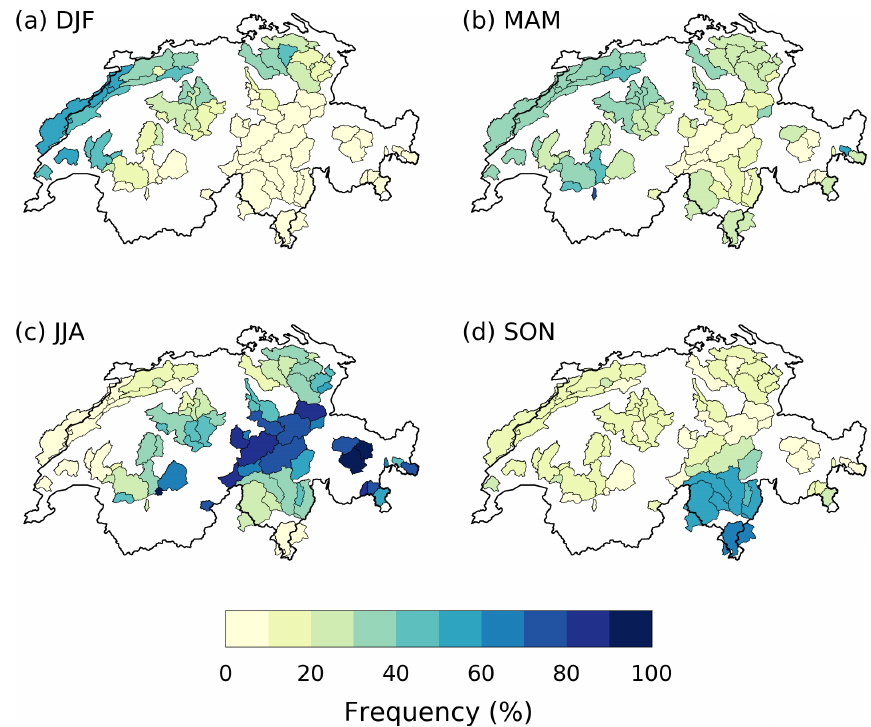
Figure 3. Seasonal frequency of exceedance of annual 99th daily discharge percentile: (a) DJF, (b) MAM, (c) JJA and (d) SON.